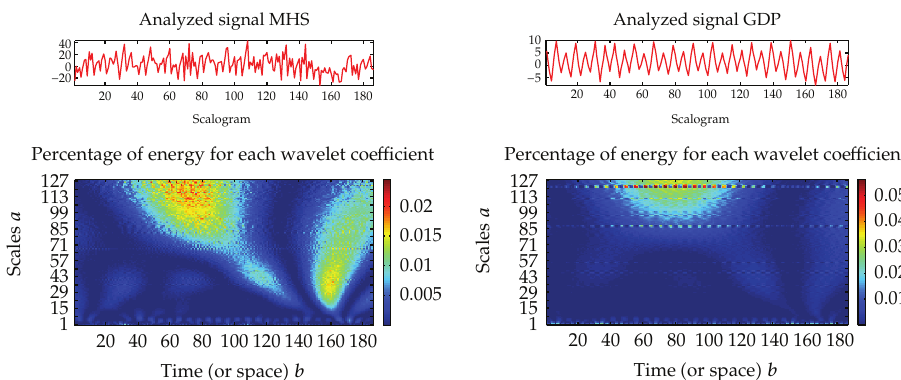
Figure 12: Energy of coe ffi cient db3 wavelet decomposition of MHS and